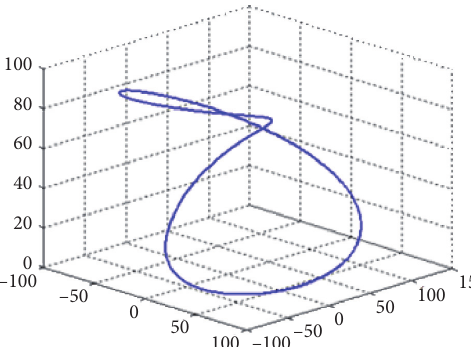
Figure 3: Motion track of the wheel cutter.